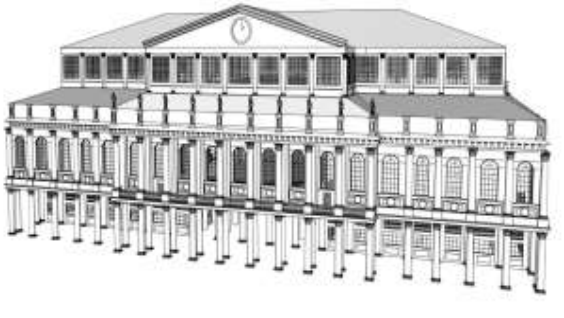
Figure 8. 3D Model of National Parliament project by